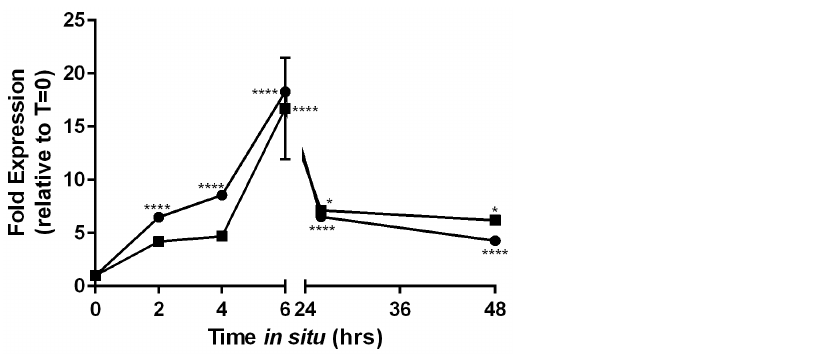
Fig. 5. Temporal gene expression of the stressosome in natural estuarine waters. Cells of CMCP6 were incubated in natural estuarine waters for 2 days using membrane diffusion chambers. Relative qRT-PCR was performed on samples collected at several time points and expression of select stressosome genes ( rsbR , circles; rsbT , squares) was analyzed relative to 0 hrs of incubation (prior to in situ exposure). GAPDH was used to normalize expression data. Asterisks represent significant differences in expression (One-way ANOVA).